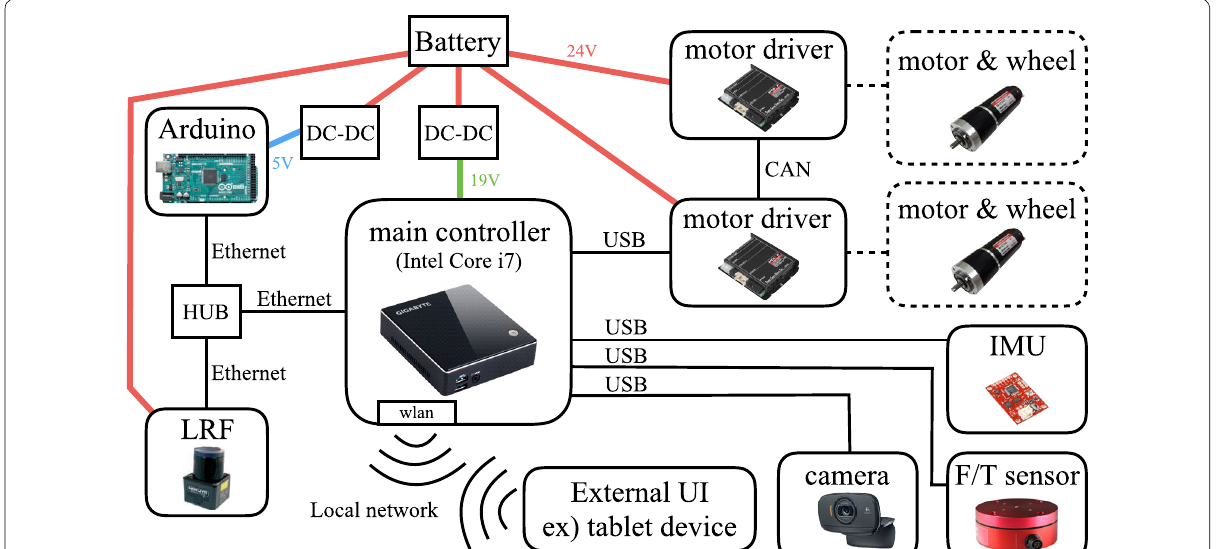
Fig. 2 Architecture of our cane robot. System structure of our cane robot including servo motors, a controller, and